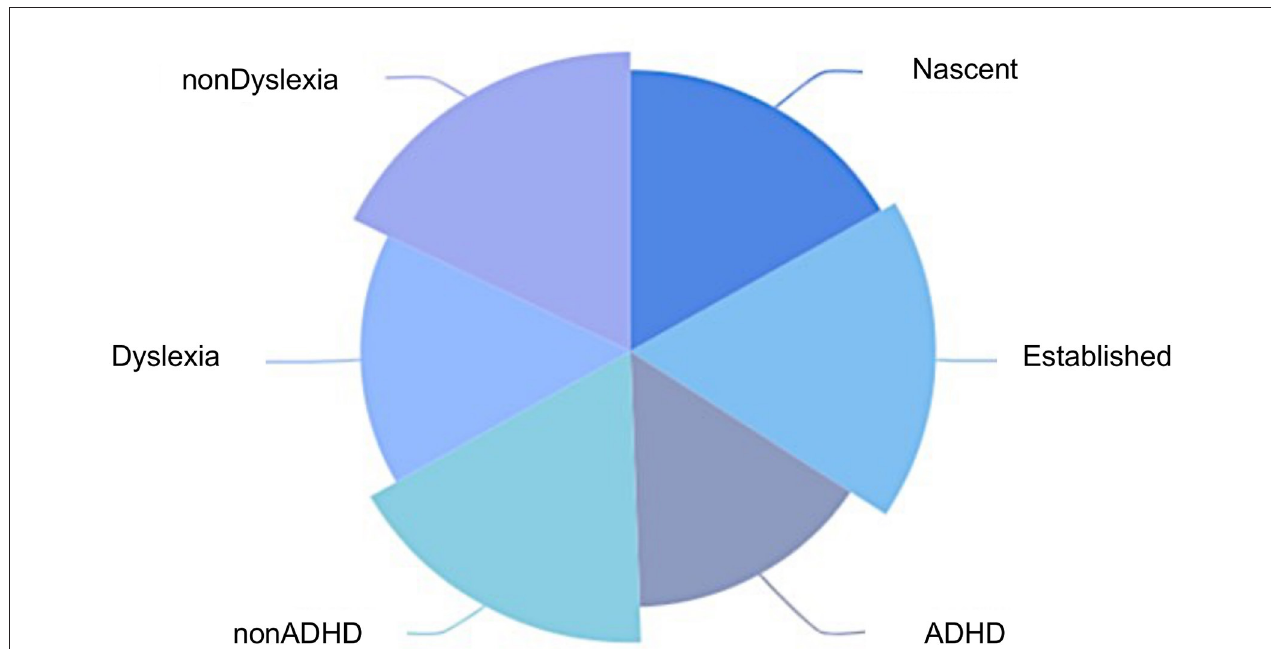
FIGURE 4 | Comparison of wellbeing score of different groups of entrepreneurs.